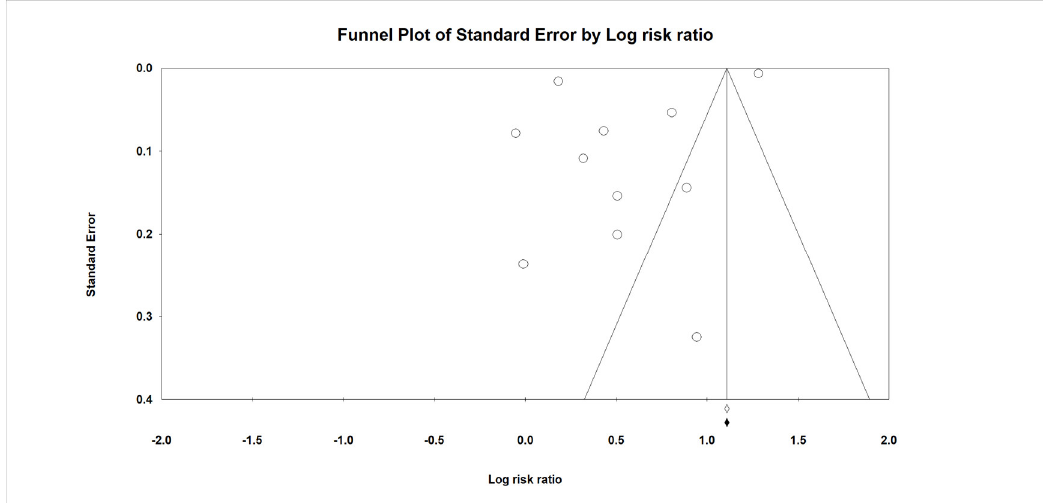
Figure 5. Publication bias in funnel plot for aortic aneurysm/aortic dissection.